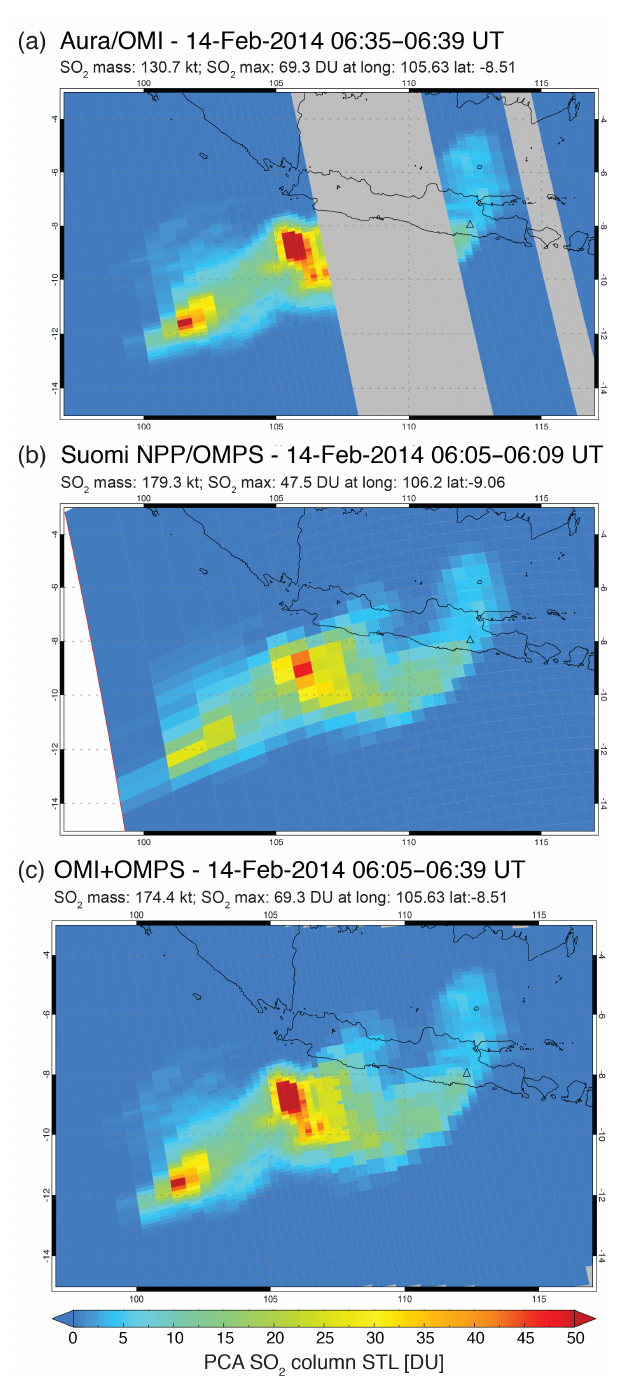
Figure 8. (a) The volcanic SO 2 plume from the Kelut eruption on 13 February 2014 retrieved using the OMI PCA algorithm (OMSO2VOLCANO) assuming the STL SO 2 profile on the fol- lowing day. Shaded areas are masked due to the OMI row anomaly. (b) Same as (a) but for OMPS PCA retrievals. (c) Same as (a) but for the merged OMI and OMPS PCA STL SO 2